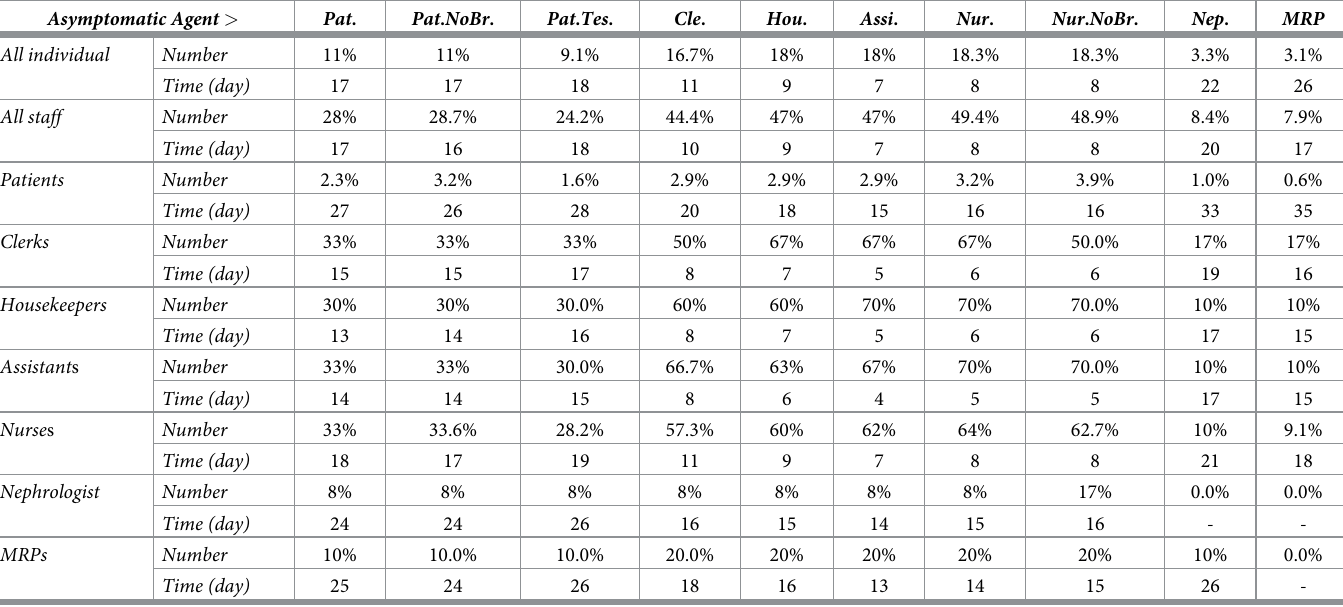
Table 7. The maximum percent of individuals exposed and its corresponding time (day) when an asymptomatic patient or staff is coming to the dialysis unit. Asymptomatic Agent > Pat